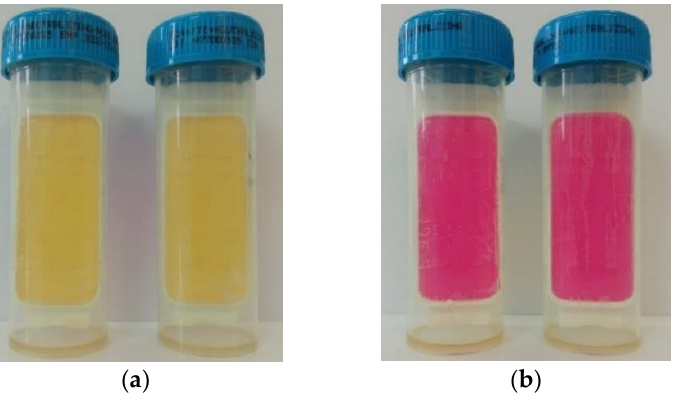
Figure 10. Example plates for microbiological stability testing: ( a ) microcount ® duo plate for total bacterial colonies count, ( b ) microcount ® duo plates for yeasts, fungi, and molds culture.